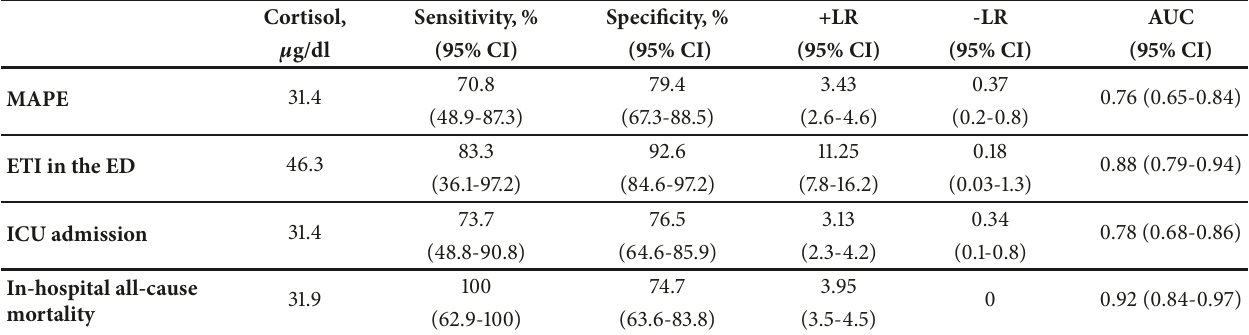
Table 3: The ROC curve analyses for